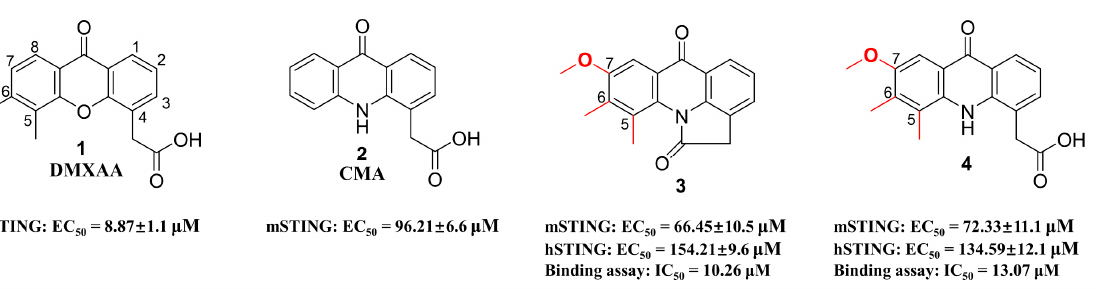
Figure 2. Chemical structures of compounds 3 and 4 with data on their biological activities. EC 50 values of compounds 1–4 were measured by STING reporter cells, and the binding IC 50 s were measured by STING competition binding kits.